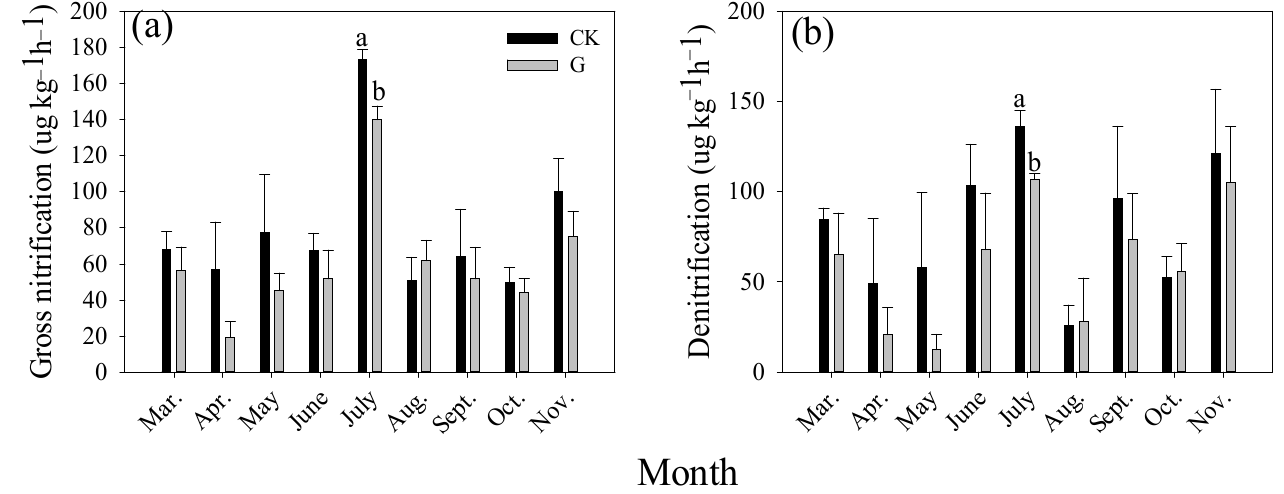
Figure 2. Monthly gross nitrification (GN) ( a ) and denitrification (DN) ( b ) in enclosure (CK) and heavy grazing (G) treatments. Different lowercase letters indicate a significant effect between treatments ( p < 0.05).